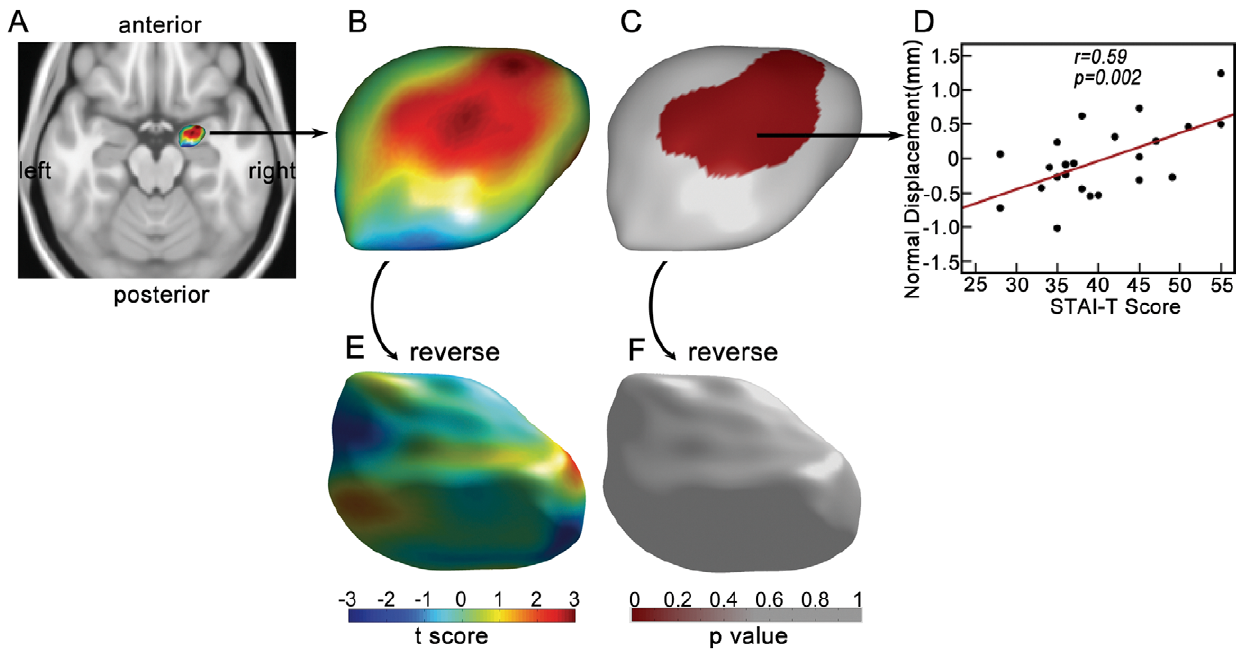
Figure 4. The correlation between normal displacement and trait anxiety. A) The rendering of right amygdala. The figure is shown from direction of superior to inferior. B) Dorsal view of T-statistic map for correlation between normal displacement of right amygdala and STAI-T scores. C) Dorsal view of P-statistic map. Only significant surface clusters (p=0.043, cluster-level, corrected) are colored. Only one cluster (red) was survived as shown. D) The scatter plot showing averaged normal displacement within the surface cluster versus STAI-T score. The red line is the regression line. E) Ventral view of T-statistic map. F) Ventral view of P-statistic map. Notably, left amygdala was not shown because no significant results were found.